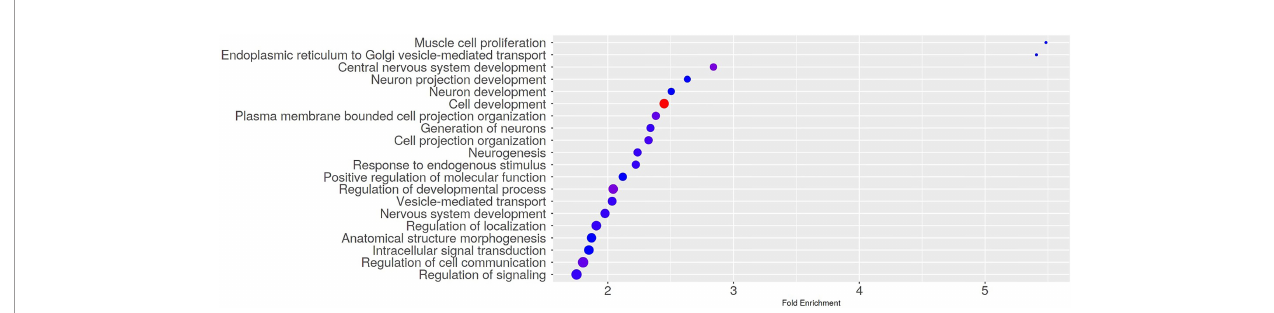
FIGURE 3 | Gene Ontology Biological Process Enrichment results. The dotplot shows the top 20 signi fi cantly enriched GO terms. The Gene Ontology Biological Process Enrichment Analysis was run using the web app ShinyGO (v0.741) with the FDR cutoff set to